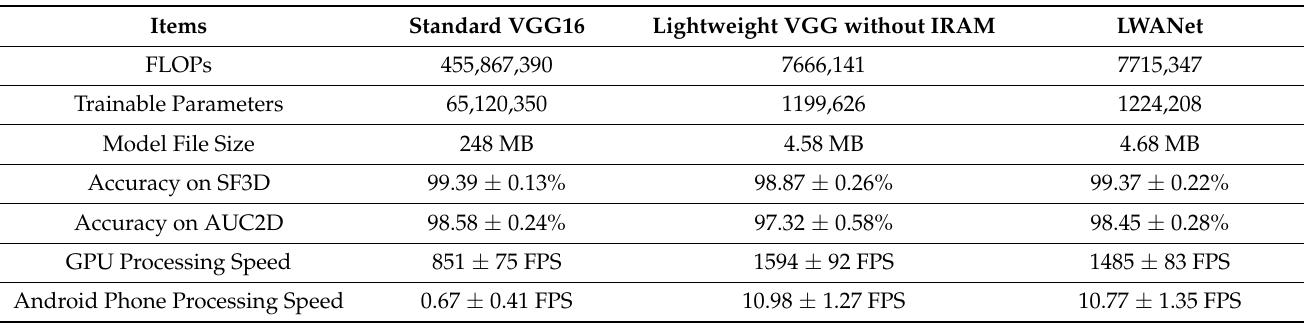
Table 5. Ablation study evaluation.